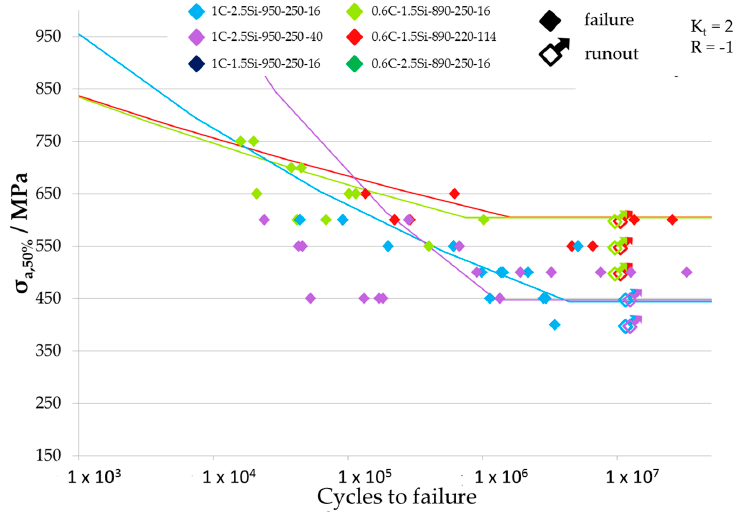
Figure 9. Woehler curves of the variants tested at specimens with K t = 2 and a load ratio R = − 1.